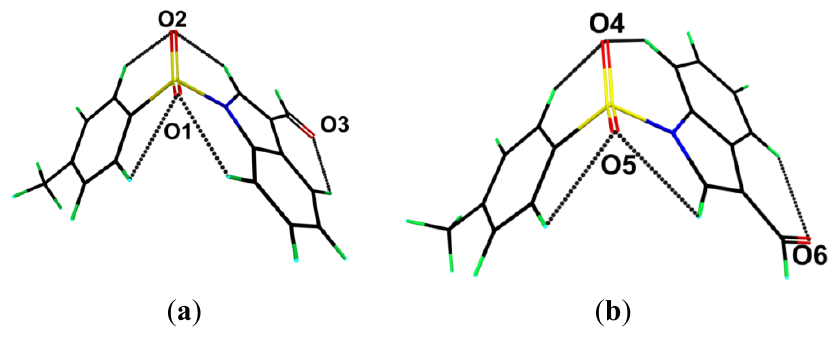
Figure 6. Geometry optimised molecules for the ( a ) S1- and ( b ) S2-containing molecules of 1 . Details of the intramolecular C-H···O interactions are tabulated in Table